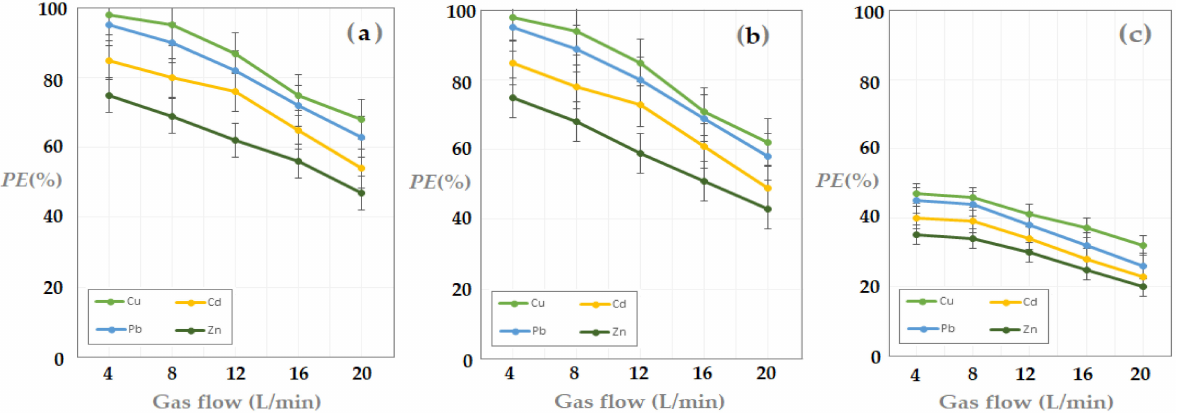
Figure 14. Hydrogen sulfide pertraction efficiency ( PE %) vs. gas flow mixture: nitrogen ( a ), methane ( b ), and carbon dioxide ( c